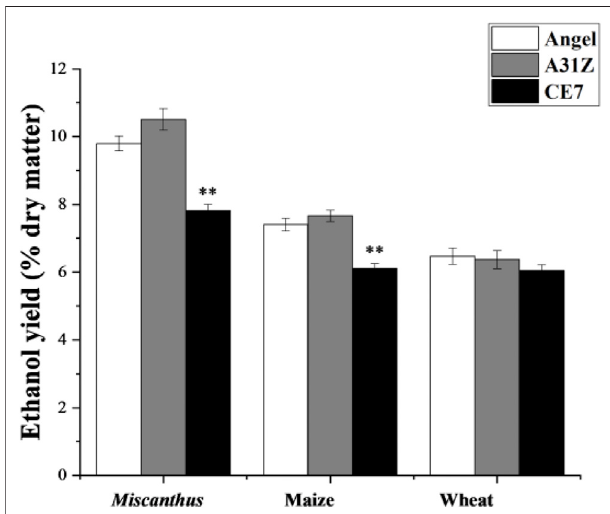
FIGURE 4 | Time-dependent ethanol yield (% dry matter) using Miscanthus , maize, and wheat straw as feedstock with strains Angel, A31Z, and CE7. All differences are statistically signi fi cant (*** p < 0.001; ** p < 0.01; * p < 0.05).